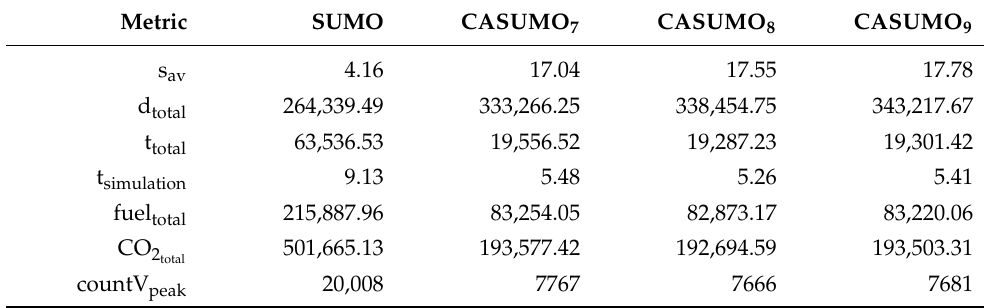
Table 8. Results for 50 K+ simulated vehicles in